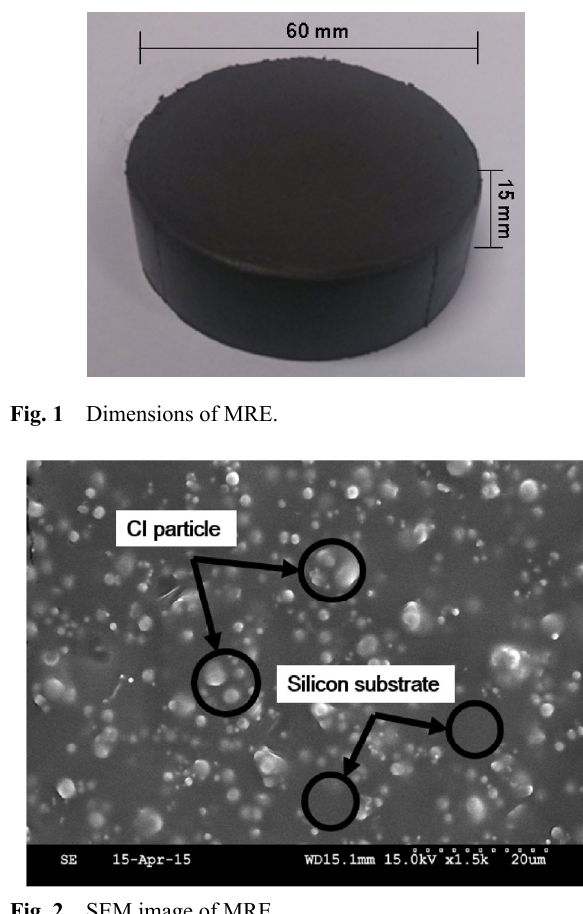
Fig. 2 SEM image of